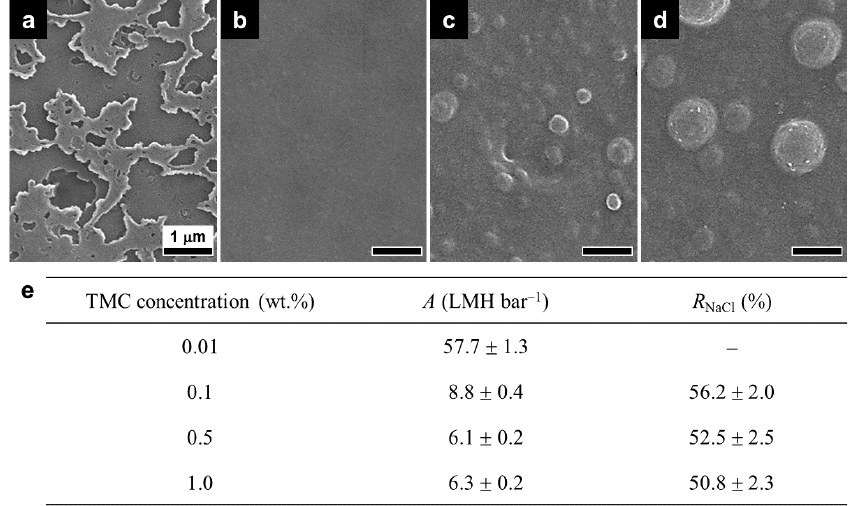
Figure 3. Surface morphologies and RO performance of the PIPA interlayers prepared with various TMC concentrations. ( a – d ) SEM surface images and ( e ) water permeance ( A ) and NaCl rejection ( R NaCl ) of the PIPA interlayers prepared at 0.5 wt.% PIP with different TMC concentrations: ( a ) 0.01, ( b ) 0.1, ( c ) 0.5, and ( d ) 1.0 wt.% TMC.